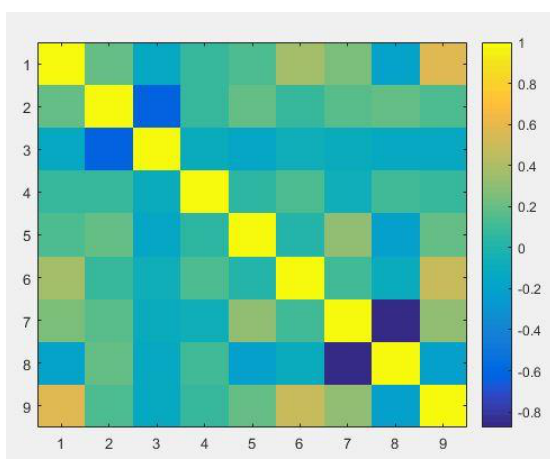
Figure 1. Correlation matrix for general centrality criterions